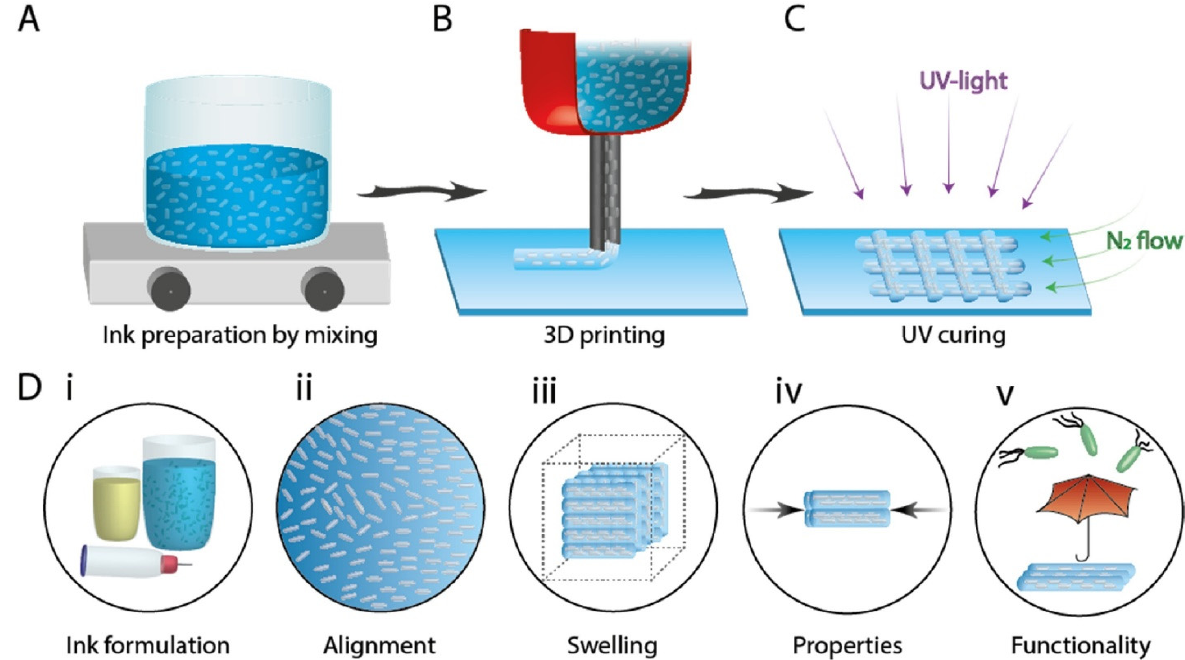
Figure 4. Illustration of the steps involved in the preparation of 3D-printed functional CNC-based hydrogels, involving: ( A ) ink formulation, ( B ) ink writing of cellulose-based polymer ink, ( C ) post-treatment to cure the printed construct, and ( D ) ( i – v ) characteristics of inks and printed constructs, reprinted from ref. [53].